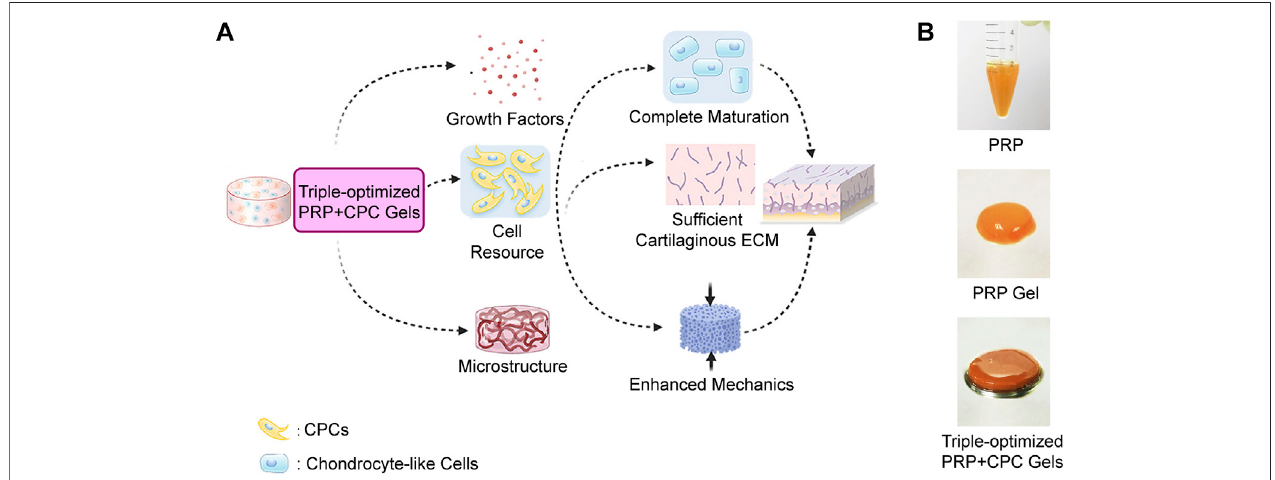
FIGURE 3 | Cellular, biochemical, and biomechanical triple-optimized PRP + CPC constructs enhance cartilage regeneration. (A) Schematic of the optimization strategy and potency of cartilage regeneration. (B) Gross appearance of PRP, PRP gel and triple-optimized PRP + CPC construct. Reproduced with permission from Wang et al.